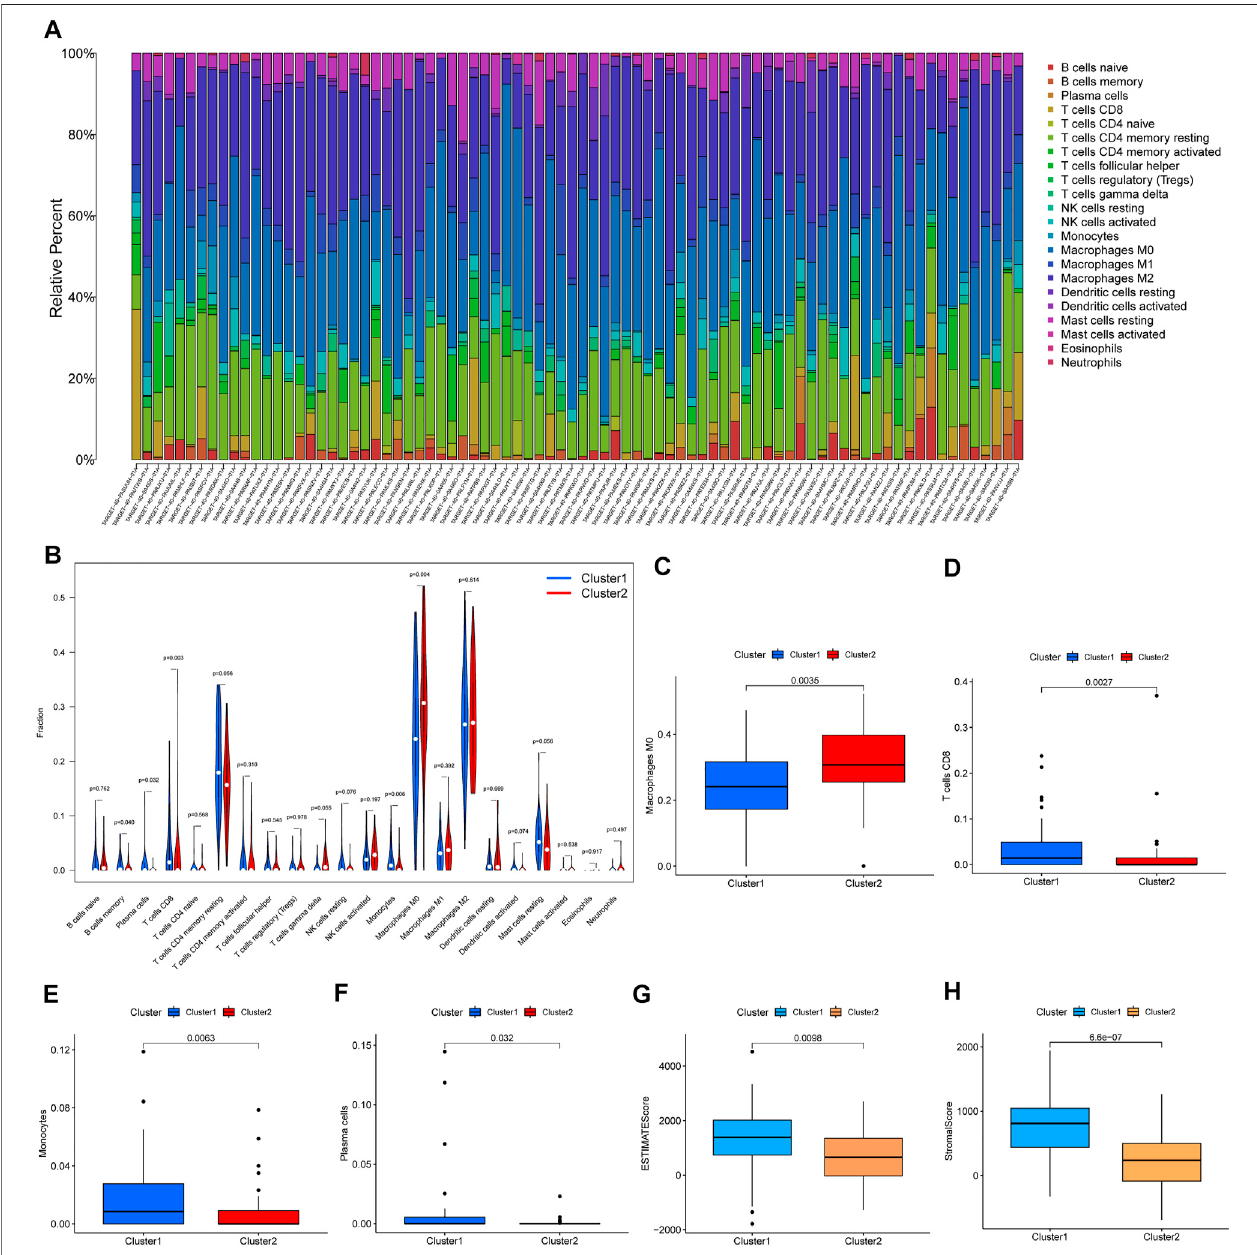
FIGURE 3 | Immune in fi ltration and the immune microenvironment in the two clusters. (A) The proportions of 22 types of immune cells in 84 samples. (B) The signi fi cant analysis for the same type of immune cell proportions in the two clusters. (C – F) The results for proportions of macrophages, CD8 T cells, monocytes, and plasma cells. (G,H) ESTIMATE score and stromal score in two